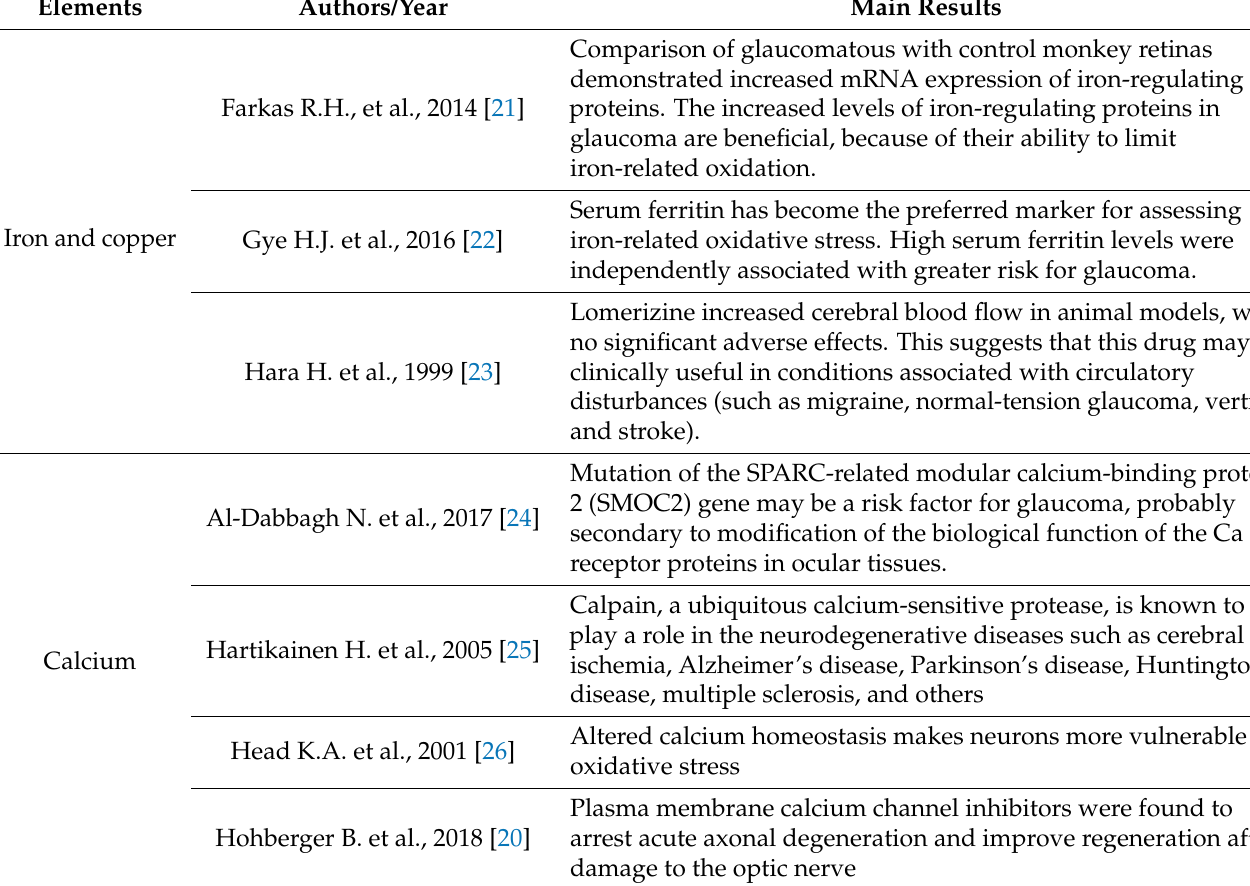
Table 1. Main studies assessing the role of trace elements in neurodegenerative eye diseases.